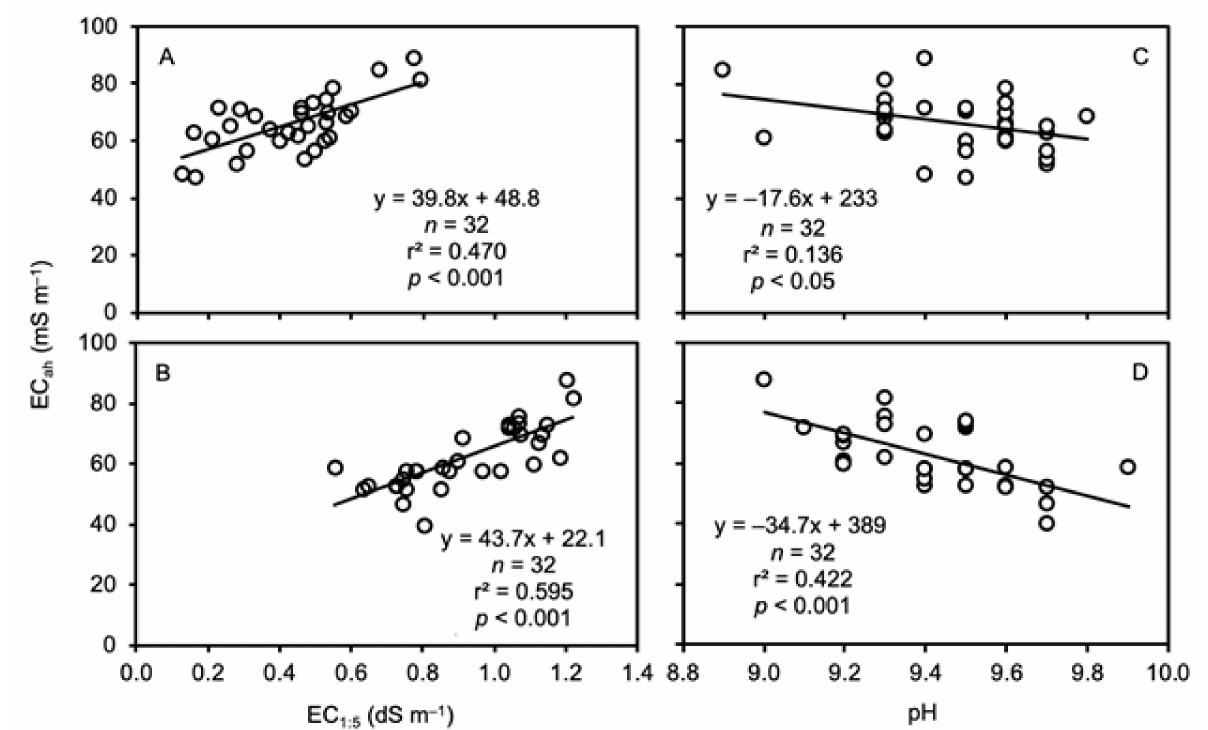
Figure 9. Correlations between EM38 readings in the horizontal orientation (EC ah ) and other soil variables: ( A ) EC ah and EC 1:5 at 50–70 cm (2019), ( B ) EC ah and EC 1:5 at 90–120 cm (2020), ( C ) EC ah and pH at 50–70 cm (2019); ( D ) EC ah and pH at 90–120 cm (2020). The soil was a Vertic Calcic Calcisol located on Merredin Research Station ( − 31 ◦ 30 (cid:48) 25 (cid:48)(cid:48) S, 118 ◦ 13 (cid:48) 04 (cid:48)(cid:48)